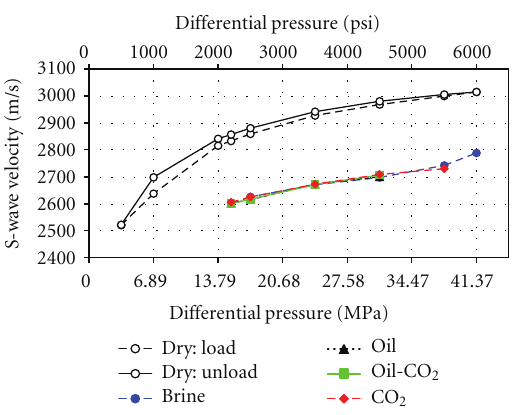
Figure 9: P- and S-wave velocities for the low-permeability number 1 sample versus di ff erential pressure for dry rock, brine saturated, and when flushed with live oil, the oil-CO 2 mixture, and CO 2 . (Note dry rock velocities were recorded at 20 ◦ C, fluid-saturated velocities were recorded at 63.9 ◦